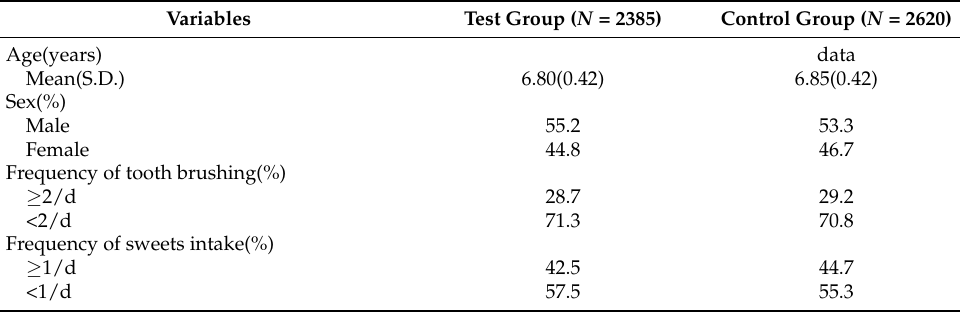
Table 1. Descriptive statistics at baseline for children who completed the